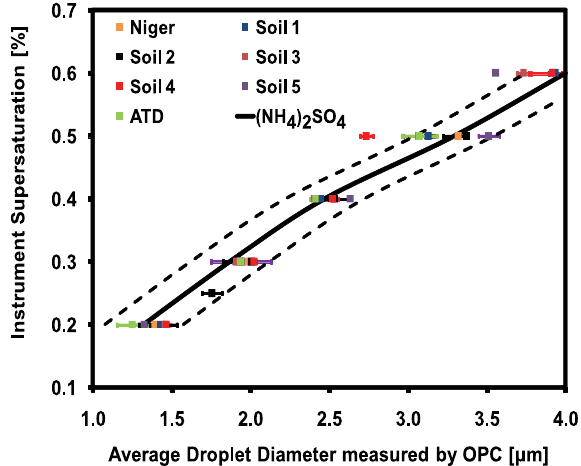
Fig. 6. Activated droplet sizes of wet generated clays and calcite CCN with s c equal to the instrument supersaturation. Error bars represent variability in droplet sizes as measured by the OPC at same instrument supersaturation. Dashed lines represent ± 0.25µm variability in (NH 4 ) 2 SO 4 droplet